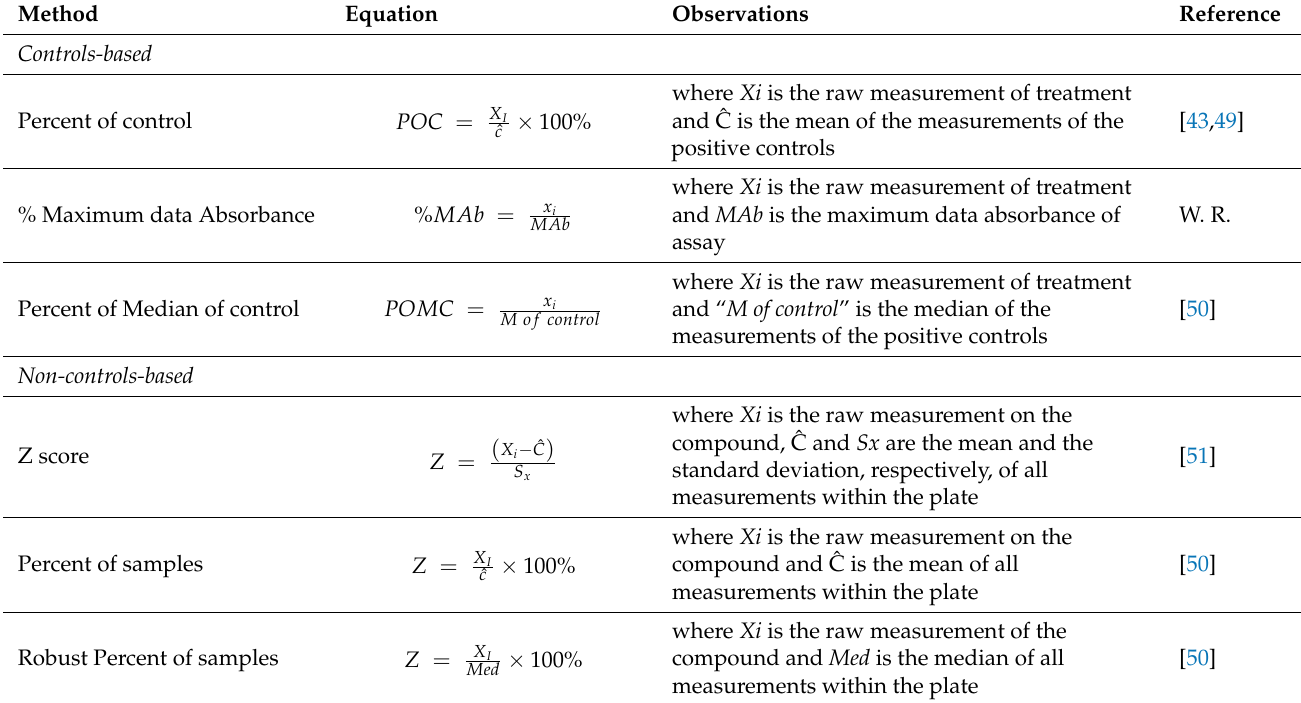
Table 4. Normalization